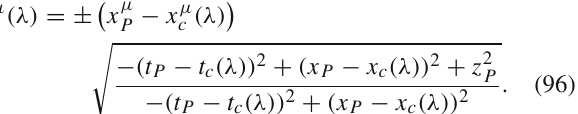
Fig. 10 Open spacelike curves at varying Poincaré time t , with both endpoints reaching the Poincaré horizon. The curve on the left is given by (85) with τ = π/ 4 ,(cid:3) = π/ 4. In global coordinates it corresponds to a circle that barely fits within the Poincaré wedge, and touches the hori- zon at a single point. The curve on the right has τ = π/ 2 ,(cid:3) = π/ 4, and